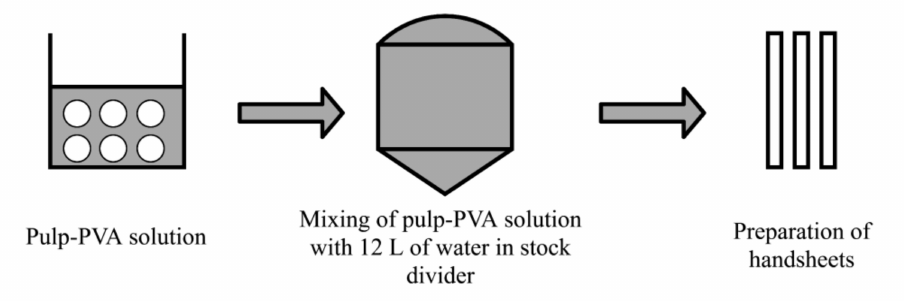
Figure 7. Papermaking